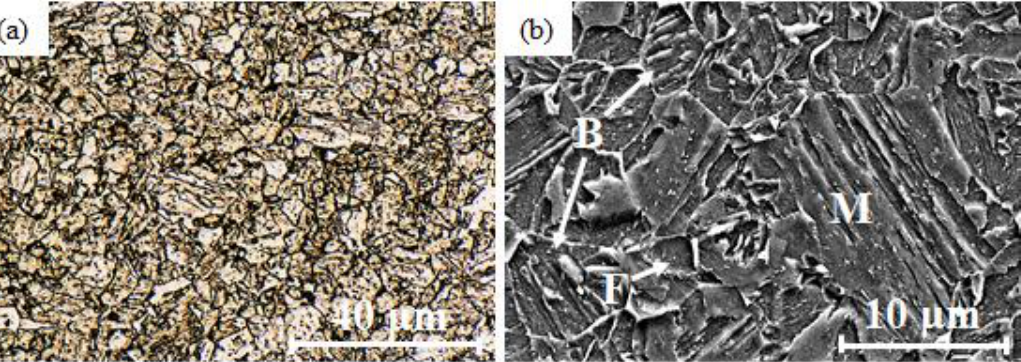
Figure 5. ( a ) LOM and ( b ) SEM images from the 350 °C die-quenched microstructure of Ductibor ® 1000-AS (B: bainite and M: martensite).